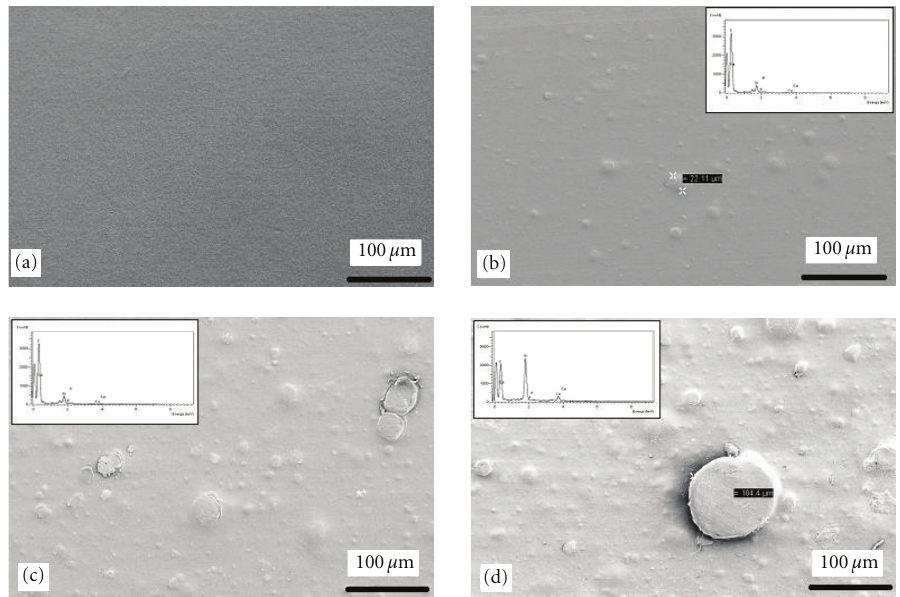
Figure 10: SEM micrograph of (a) CN6F, (B) N6CF2, (C) N6CF5, (d)